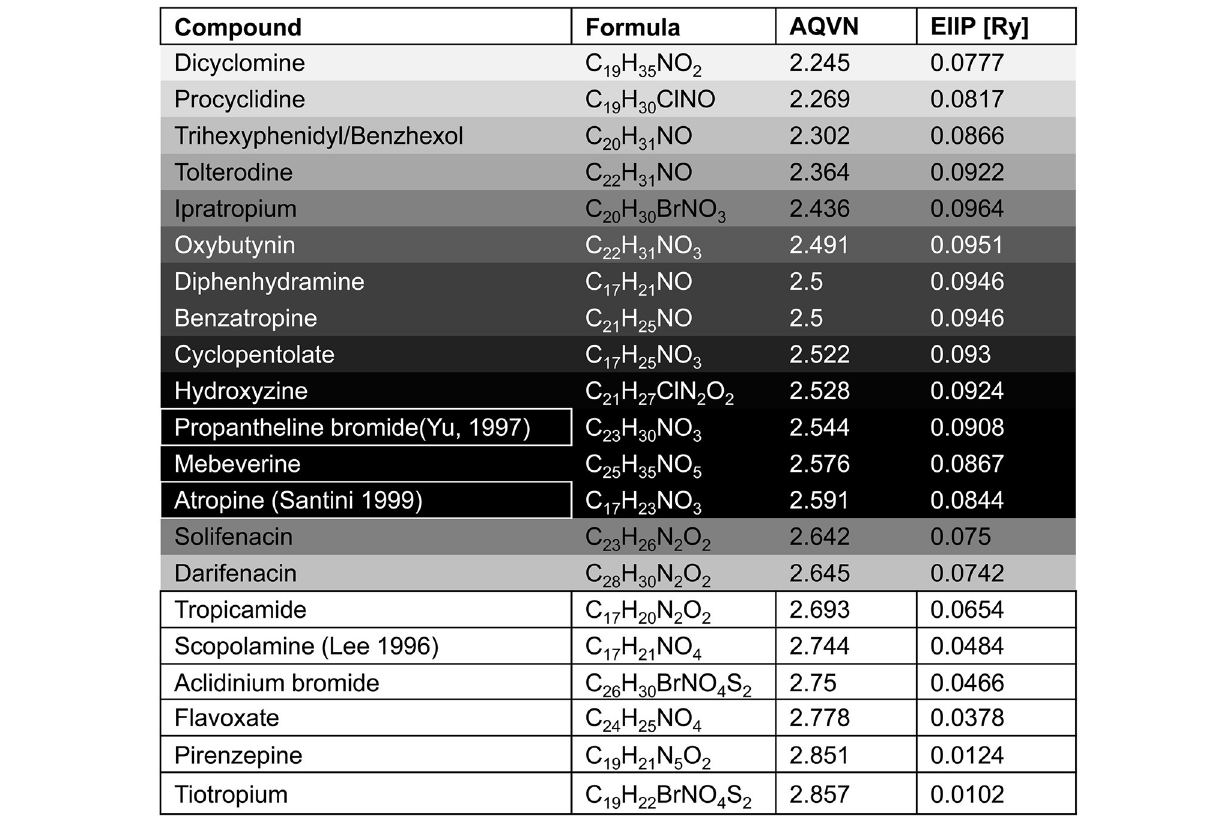
Frontiers in Neuroscience |